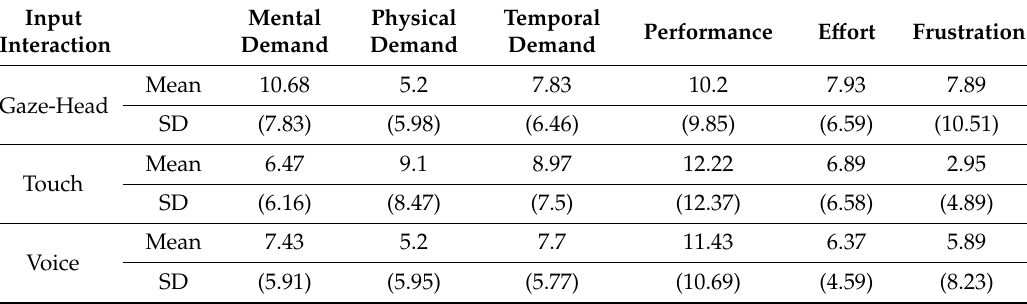
Figure 10. The six dimensions of NASA-TLX for the three input interactions. Table 2. The mean (M) and standard deviation (SD) values for the six dimensions of NASA-TLX for the three input interactions.